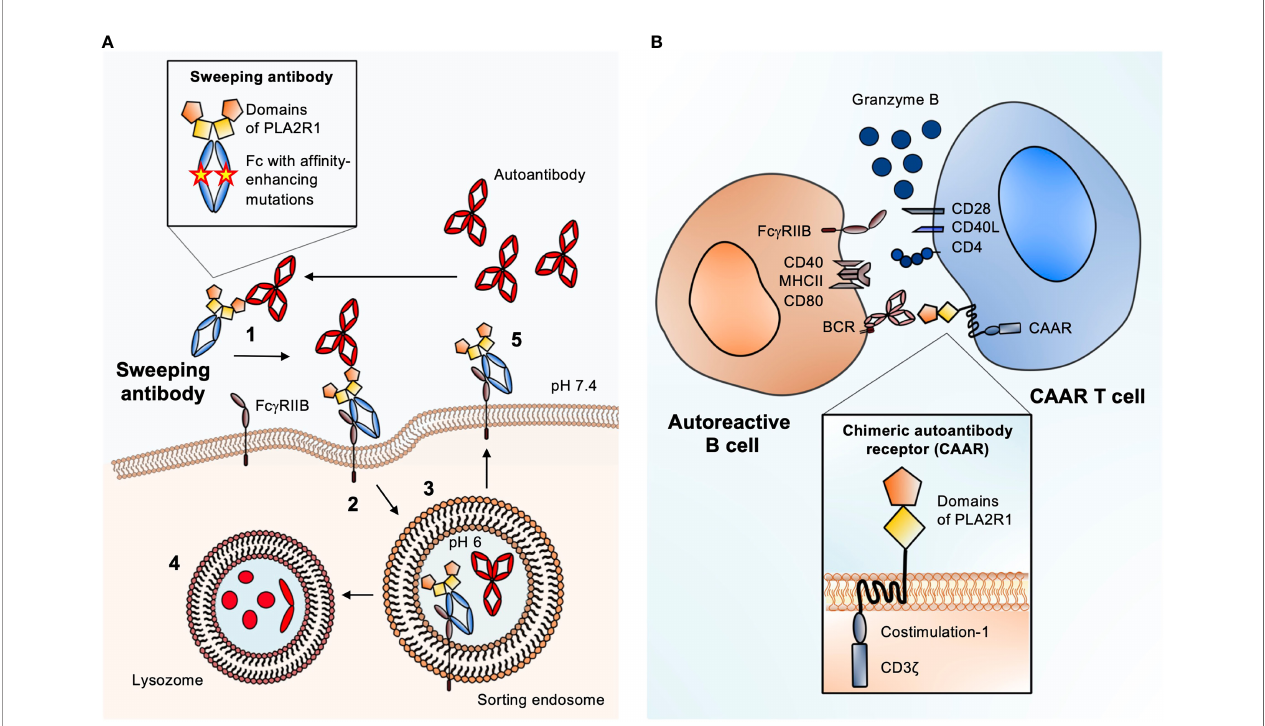
FIGURE 2 | Antigen-speci fi c therapies suited for MN. (A) Schematic of the sweeping antibody principle with enhanced Fc g RIIB binding. 1. After injection, sweeping antibody and autoantibody bind in the circulation. 2. Scavenger cells like liver sinusoidal endothelial cells (LSECs) that express Fc g RIIB bind the circulating immune complex (IC) and internalize it through pinocytosis. 3. Due to a pH shift from neutral to pH 6 inside the sorting endosome, the autoantibody is released from the IC- receptor complex. 4. The autoantibody is degraded inside the lysosome. 5. The Fc receptor-bound sweeping antibody is returned to the surface and can bind new circulating autoantibodies causing the “ sweeping ” effect. Magni fi ed: structure of a PLA2R1 sweeping antibody: The Fab part is substituted for the most N-terminal domains of PLA2R1 (cysteine-rich and fi bronectin type II) to create speci fi city for anti-PLA2R1 autoantibodies. Mutations in the Fc part of the sweeping antibody enhance the af fi nity towards Fc g RIIB. (B) Schematic of chimeric autoantibody receptor (CAAR) T cell principle. The CAAR comprises fragments of the target antigen (in this case the cysteine-rich and fi bronectin type II domains of PLA2R1), a transmembrane domain, and several intracellular signaling domains. The CAAR enables binding to a B cell, which expresses the corresponding B cell receptor (BCR), a membrane-anchored IgG corresponding to the autoantibody that is produced by the B cell. CAAR-mediated binding of the T cell to the pathogenic B cell leads to release of granzyme B, which eliminates the target B cell. Magni fi ed: structure of a second generation CAAR. It includes the autoantibody receptor as a ectodomain, here the most N-terminal domains of PLA2R, a transmembrane part and an endodomain with co-stimulation module and the CD3 z with three immunoreceptor tyrosine-based activation motifs (ITAMs). The co-stimulatory domain improves the half-life in vivo , proliferation and cytotoxity of the CAAR T